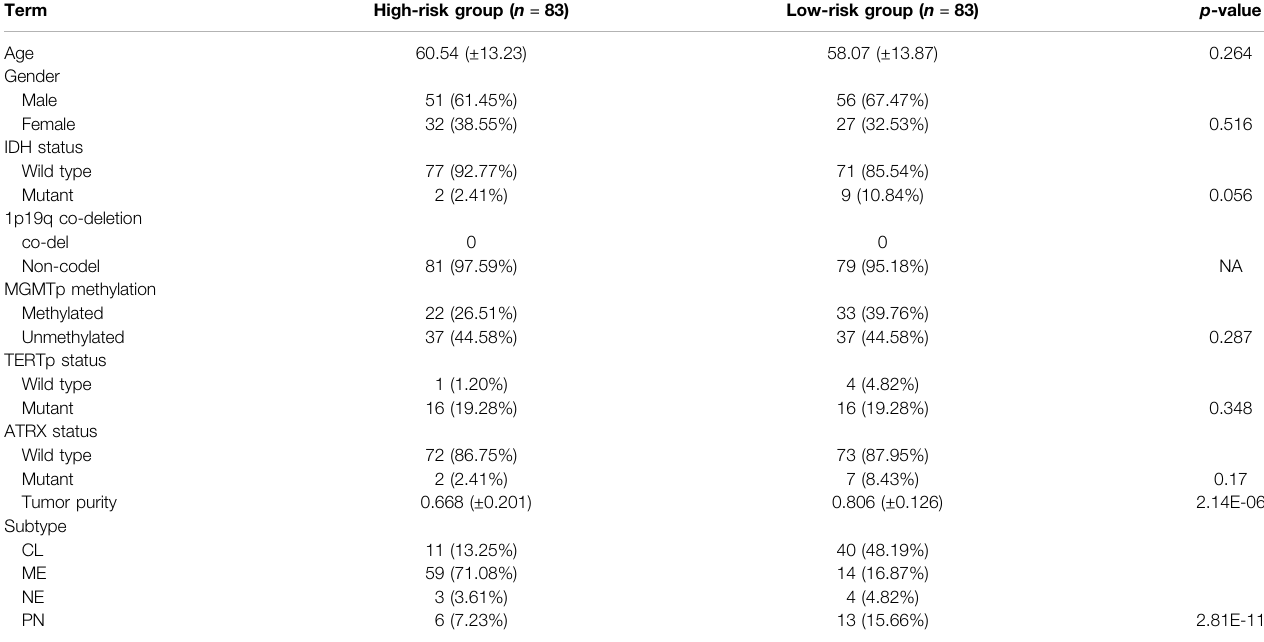
TABLE 2 | Association between the risk group and prevalent clinicopathological